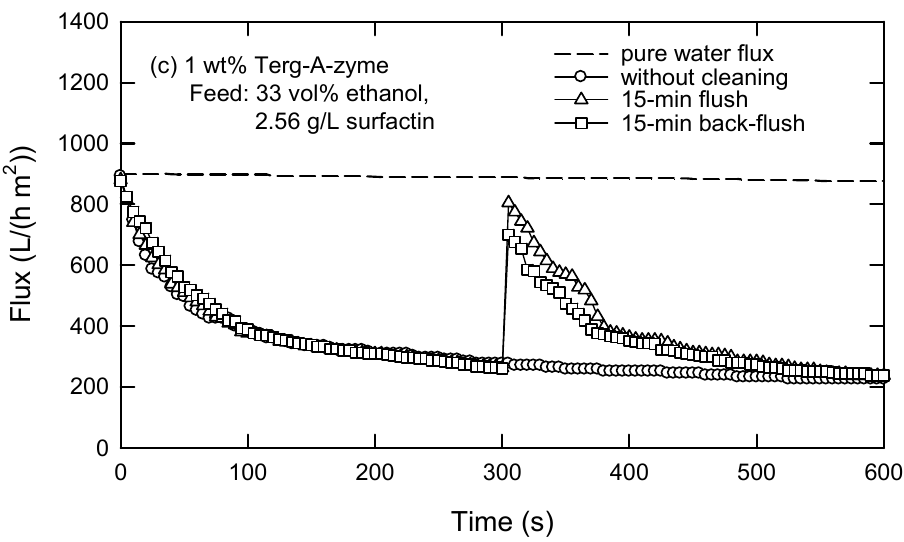
Figure 13. Cleaning of PES 100 membrane in cross-flow UF using ( a ) deionized water, ( b ) NaOH solution (pH 11), and ( c ) 1 wt.% Terg-A-zyme solution (TMP = 40 kPa, u = 0.033 m/s).